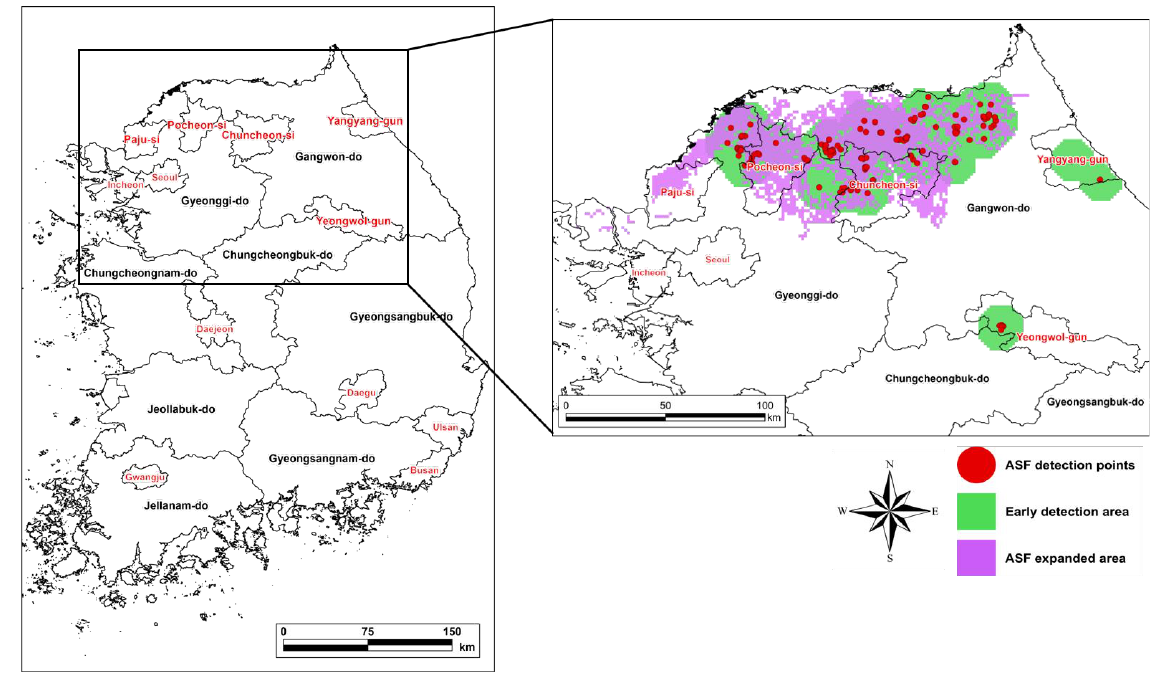
Figure 4. Model validation result. The validation period was September – November 2020.